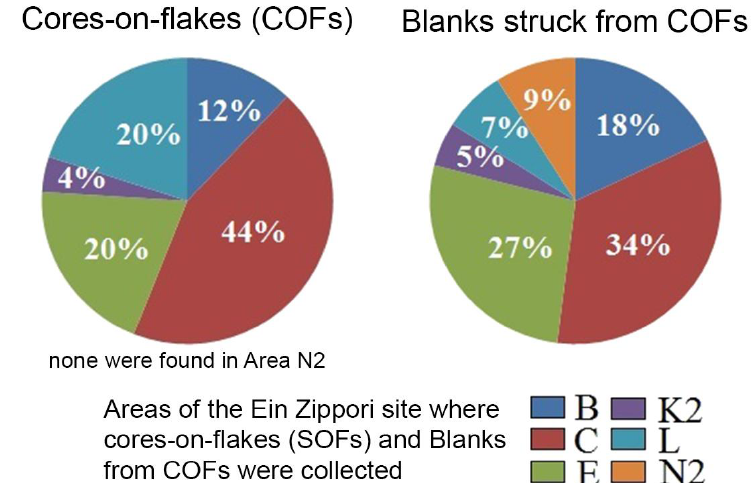
Figure 1. Percentage of the 25 cores-on-flakes (left) and the 44 blanks struck from COFs (right) in the microwear sample collected from six areas of the the Ein-Zippori site. There were no COFs from Area